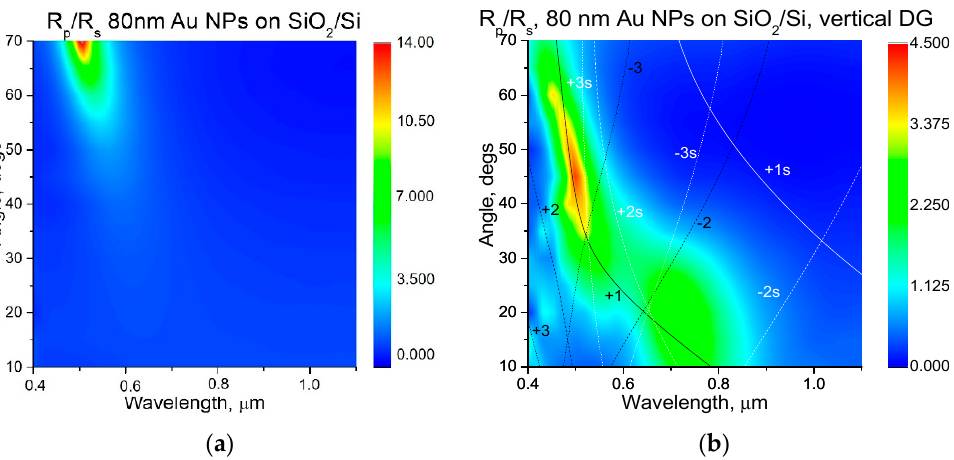
Figure 8. Comparison between samples with 80 nm Au NPs on oxidized flat Si ( a ) and on oxidized Si with vertically aligned DG. Dispersion curves ( b ) for surface-plasmon-polariton waves for two boundaries, air/gold (±1, 2, and 3) and gold/silica (±1s, 2s, and 3s), are shown for different diffraction orders 1, 2, and 3 (shown on the figures).